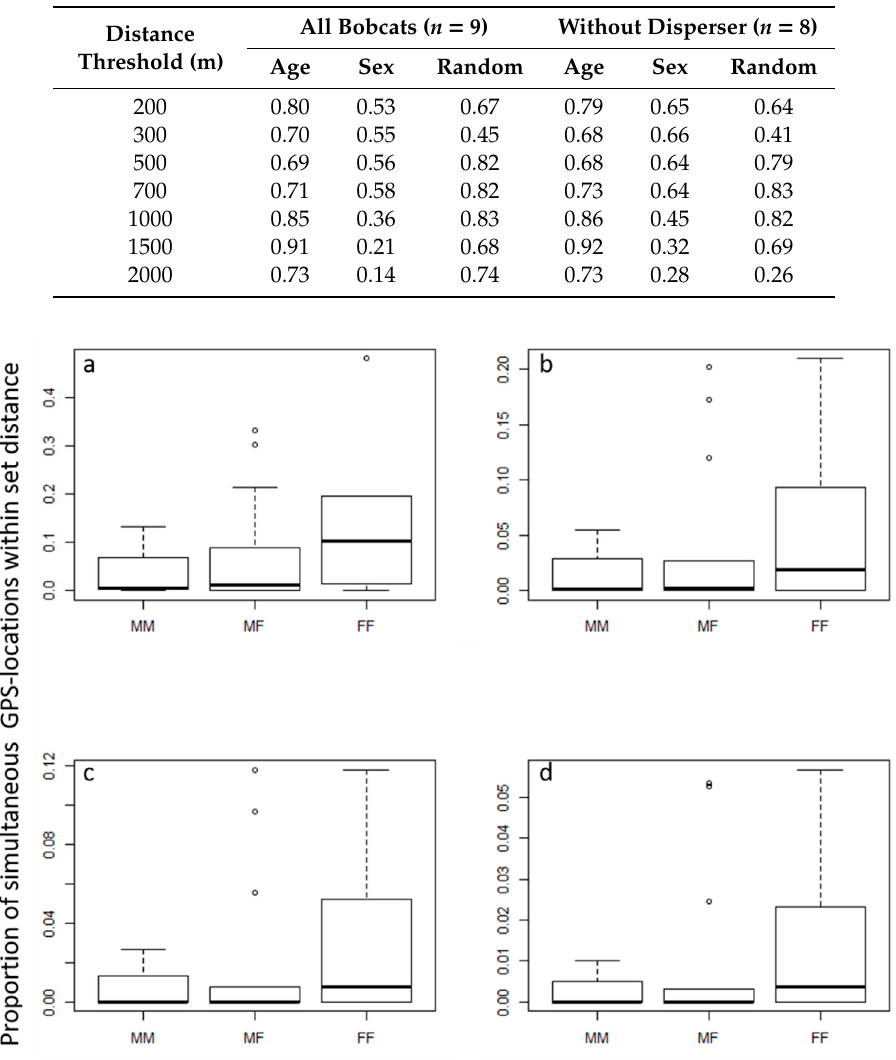
Table 1. P -values from proximity analysis (Prox) in Program R at a range of distance thresholds for simultaneous GPS-collar locations of bobcats in the Dallas–Fort Worth metroplex, Texas, USA. There were no significant differences for age or sex of pairs nor were there differences in proximity relative